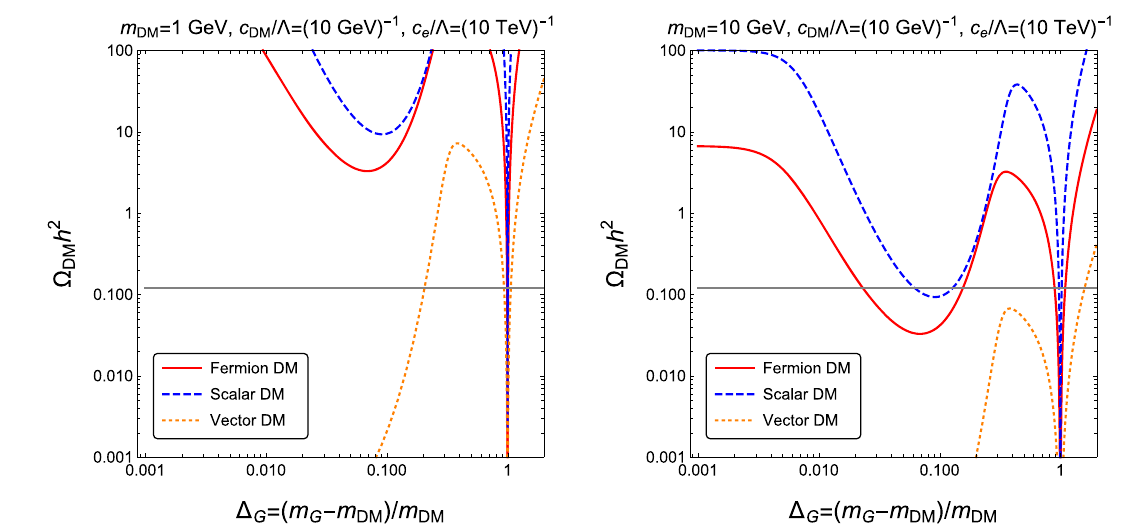
Fig. 6 Relic density as a function of (cid:15) G ≡ ( m G − m DM )/ m DM with forbidden channels included. The correct relic density is satisfied in red solid, blue dashed and orange dotted lines for fermion, scalar and vector